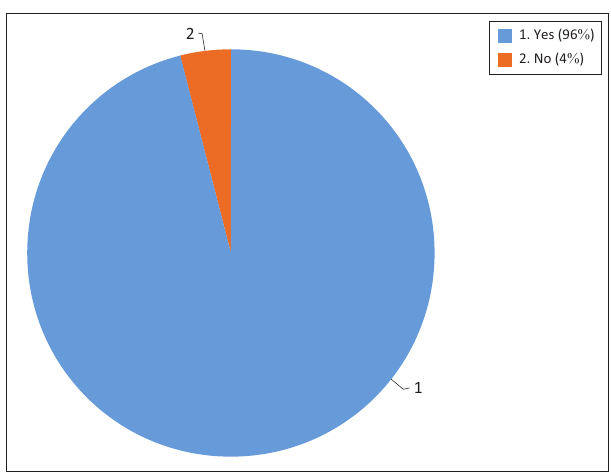
FIGURE 1: Number of respondents affected by forest and land fires in West Kalimantan